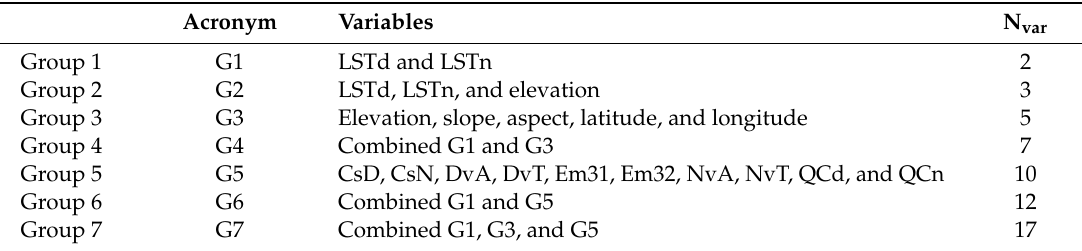
Table 3. Seven model subsets studied. The seven groups were generated to study the relations between responses and up to 17 predictor variables. N var indicates the number of predictor variables in each